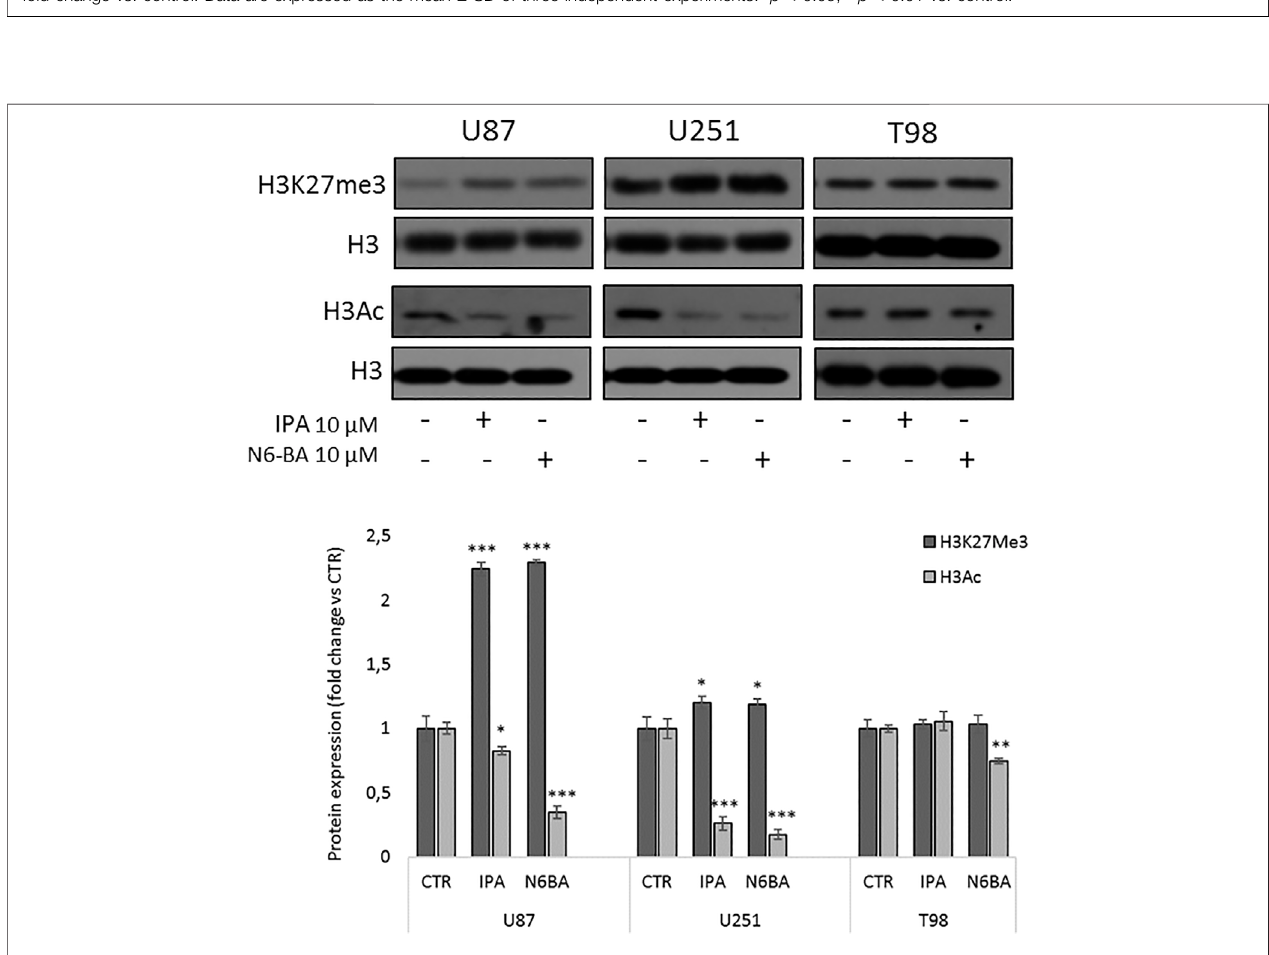
FIGURE 7 | IPA and N6-BA in fl uence histone marks associated with gene repression. Representative western blot and densitometric analysis of H3K27me3 and H3Ac in puri fi ed histone fractions of GBM cell lines treated with IPA or N6-BA after 24 h. H3 was used as a loading control. The histograms report the quanti fi cation of bands intensity expressed as mean ± SD of three independent experiments. * p < 0.05, ** p < 0.01, and *** p < 0.005 vs. control.